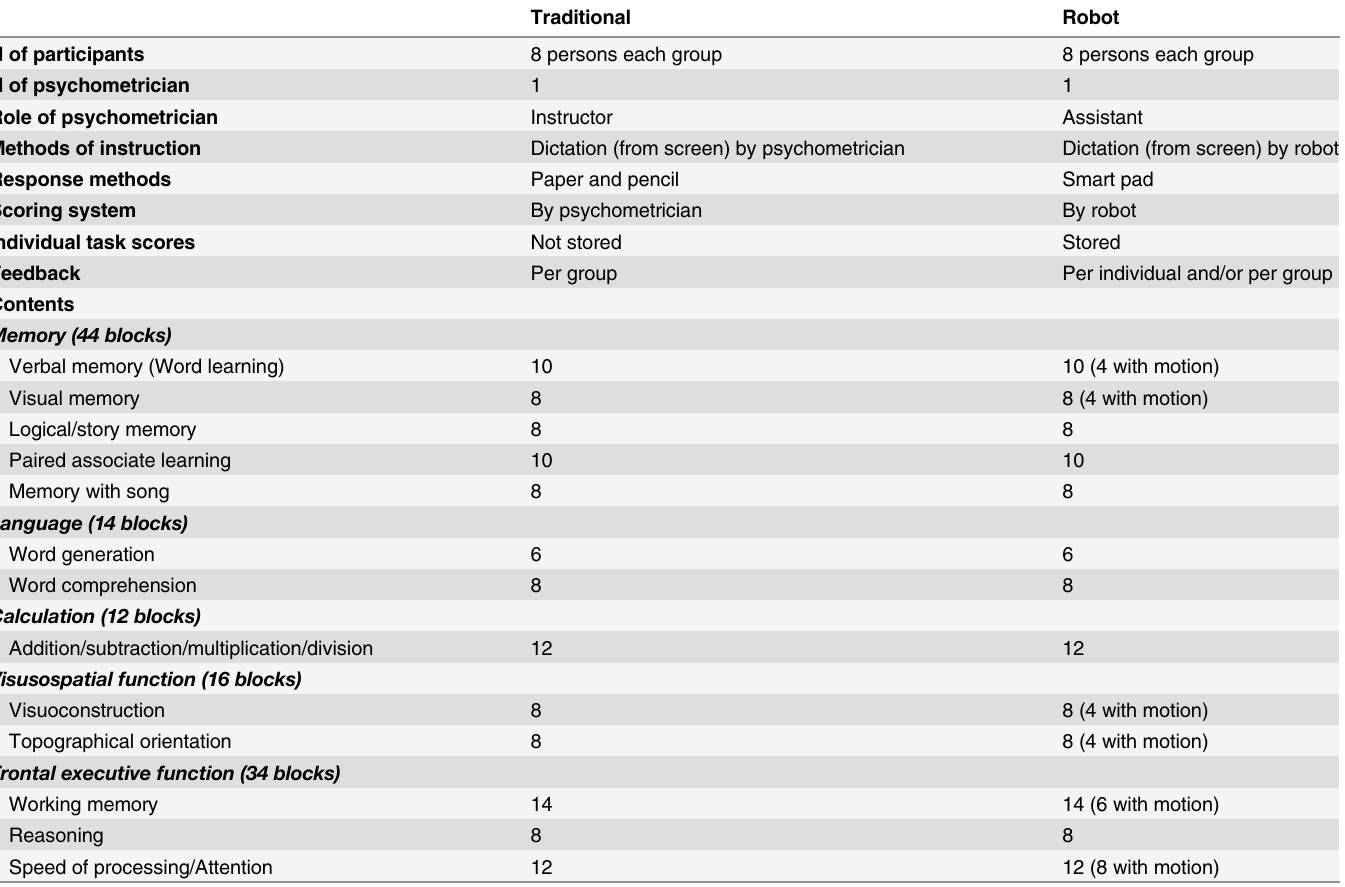
Table 2. Comparisons of traditional and robot